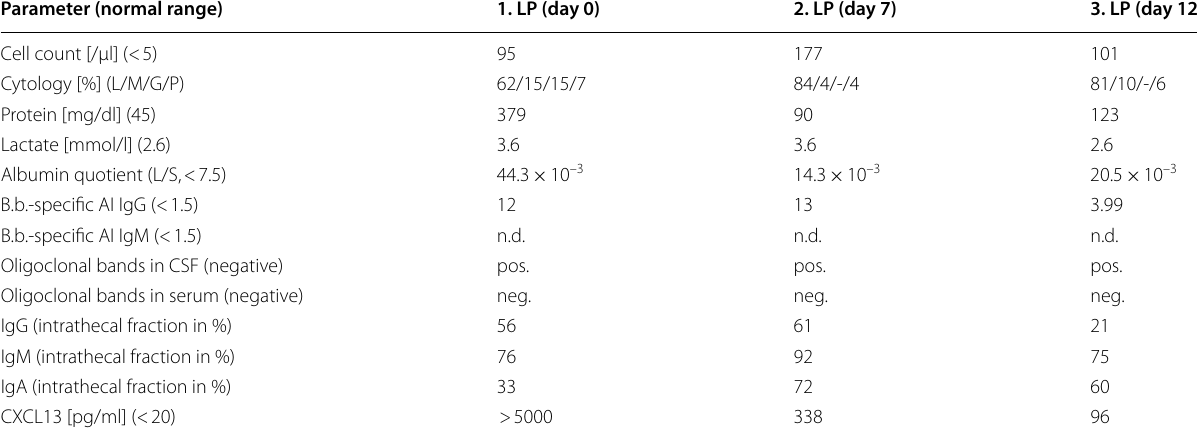
Table 1 CSF parameters at different time points